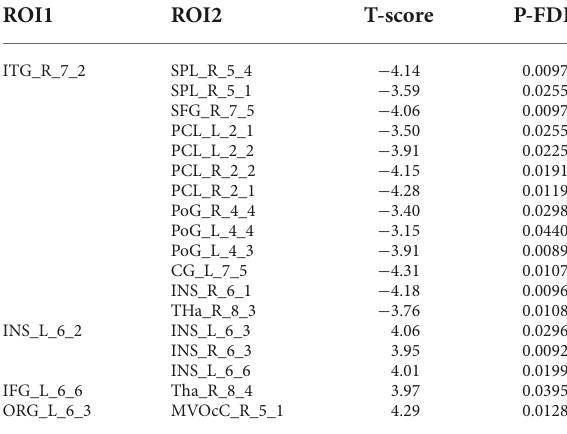
TABLE 2 Functional connections regions based on Pearson correlation.